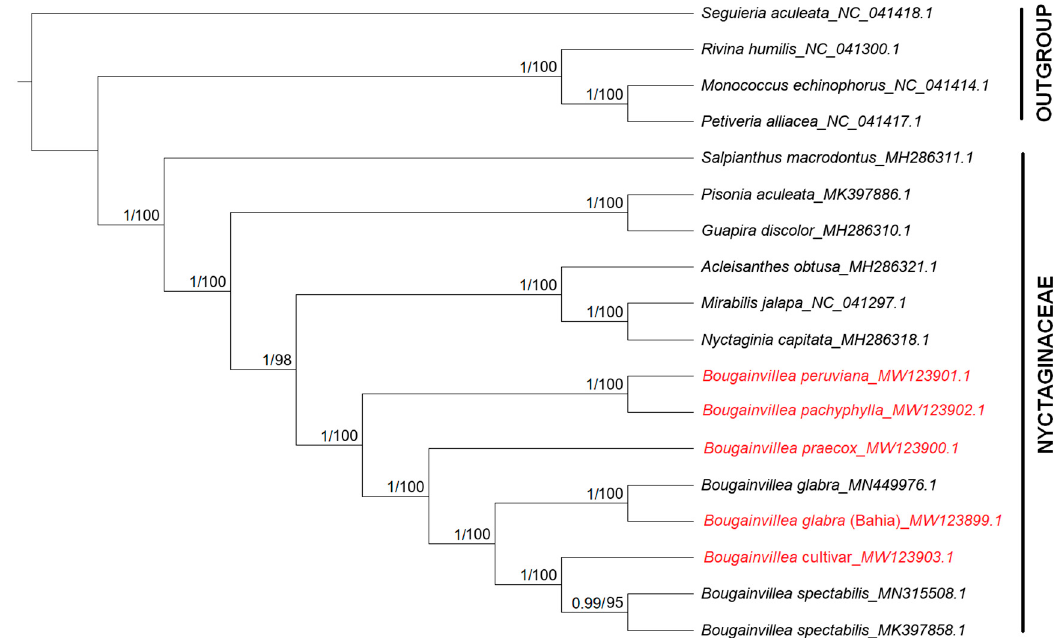
Figure 10. Maximum Likelihood (ML) and Bayesian Inference (BI) consensus tree based on the 79 concatenated protein-coding regions of 14 Nyctaginaceae cp genomes. Species from Petiveriaceae were used as outgroups. Numbers on each node represent bootstrap support and Bayesian posterior probability (BPP) values. Branches with bootstrap values > 75 and BPP values > 95 are considered as highly supported.